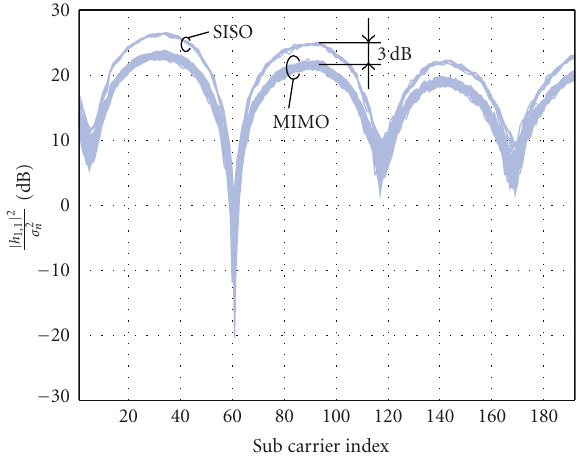
Figure 4: Estimated channel coe ffi cients for the SISO as well as the MIMO cases between transmit antenna one and receive antenna one, scenario 1, NLOS outdoor-to-indoor. The coe ffi cients are plotted over the 192 data subcarriers; the eight pilots and the zero DC carrier are left out. Note that the transmitter attenuation is included in these estimated channel coe ffi cients leading to 3dB smaller channel coe ffi cients for MIMO transmis-